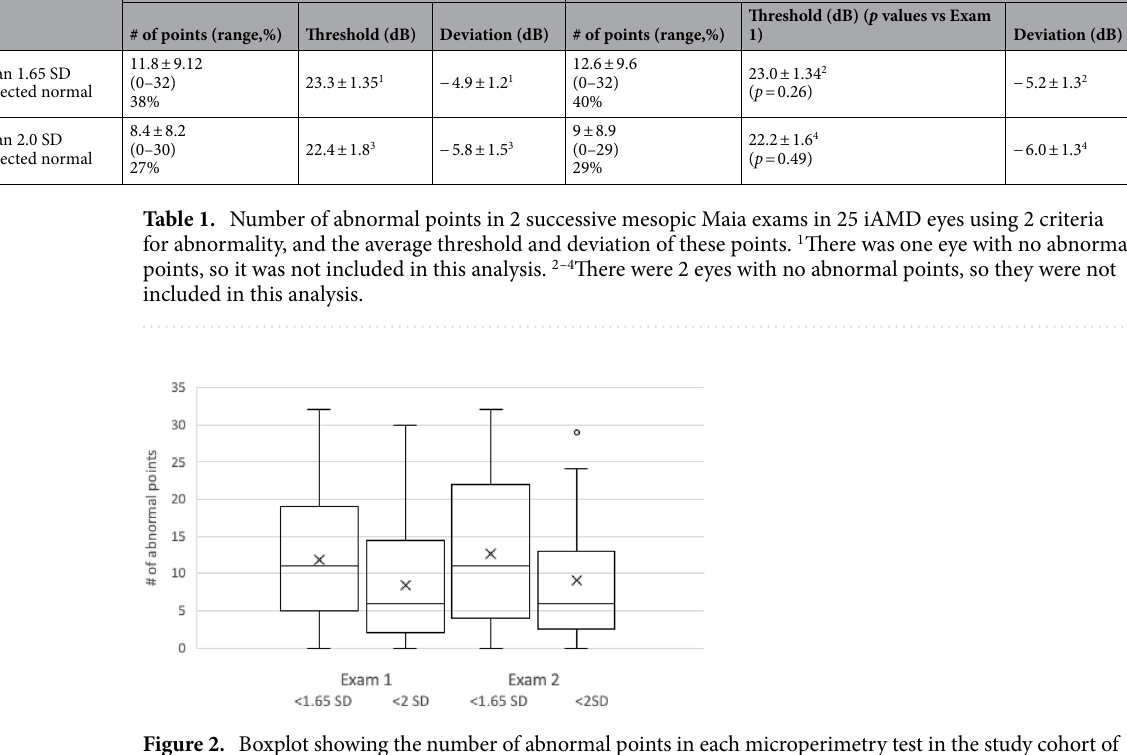
Figure 2. Boxplot showing the number of abnormal points in each microperimetry test in the study cohort of 25 eyes. The 2 leftmost plots represent the first exam, and the rightmost pair the second exam. In each pair, the left plot was generated when a point was defined as “abnormal” if its threshold sensitivity was lower than 1.65 SD (5%) of expected value in a healthy population; for the right plot abnormality was defined as < 2SD (2.5%) of normal. Each boxplot includes the maximum (upper whisker, excluding outliers), upper quartile (top of box), median (horizontal line in box), lower quartile (bottom of box), minimum (lower whisker, excluding outliers) and average (x) values. Outliers are represented by black